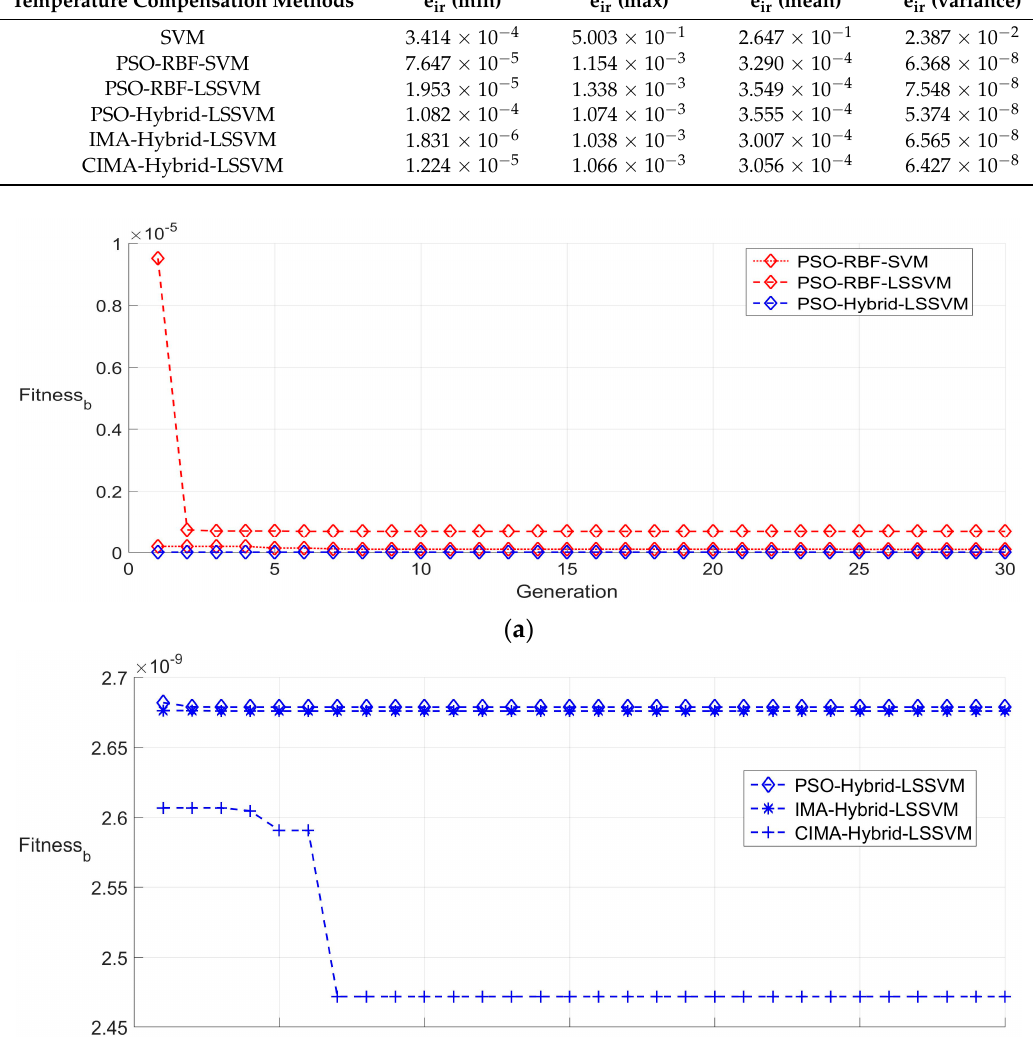
particle swarm optimization optimized RBF kernel SVM (PSO-RBF-SVM),